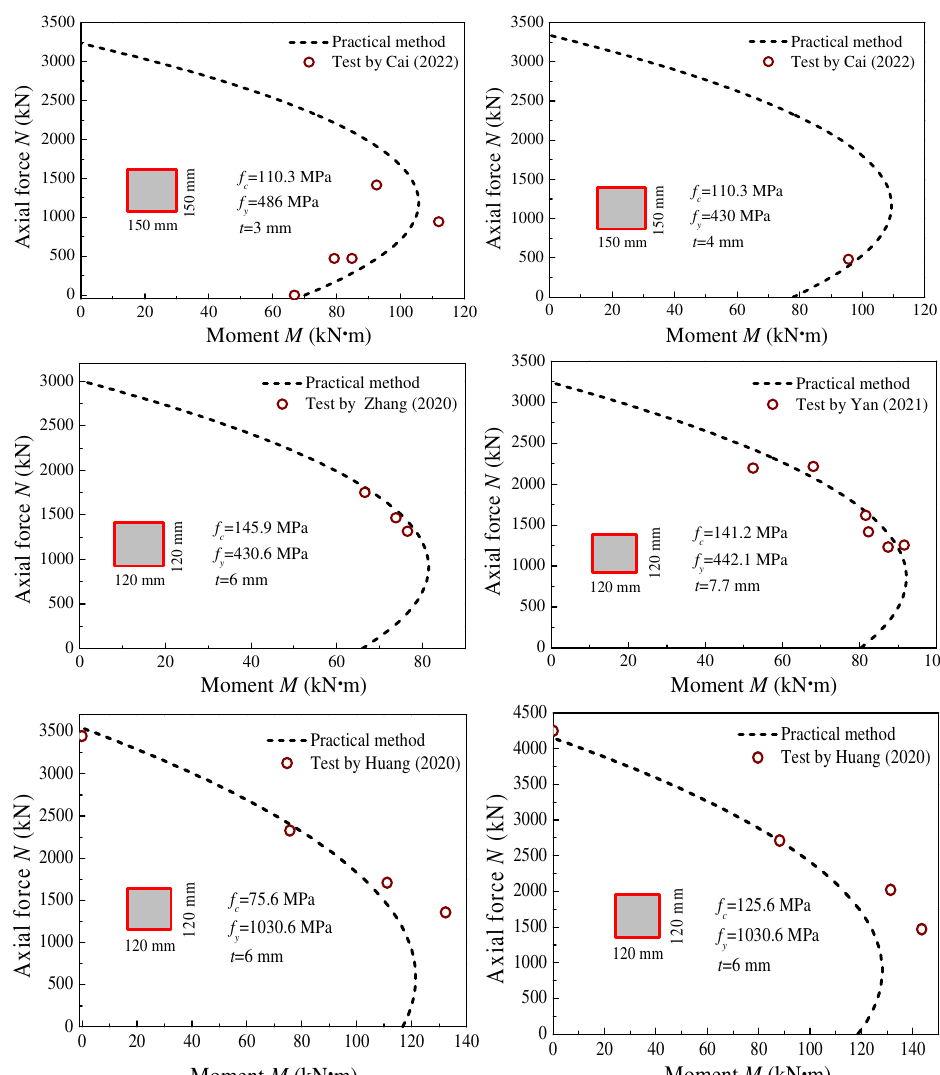
. Moment M (kN m) Figure 18. The comparison of N - M interaction curves calculated by practical method with test values. (Zhang et al. [35], Huang et al. [36], Cai [38], Yan et al. [39]).